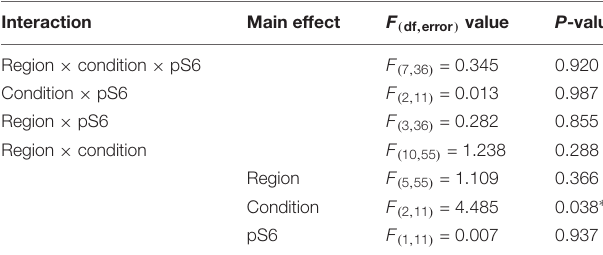
TABLE 4 | Repeated measures ANOVA results for pS6 expression.